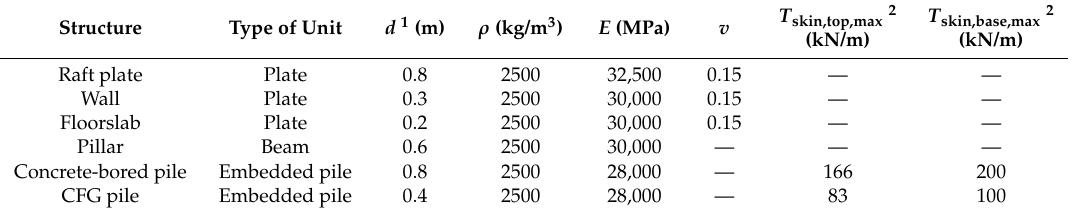
Table 2. Material parameters of structure. CFG—cement/fly